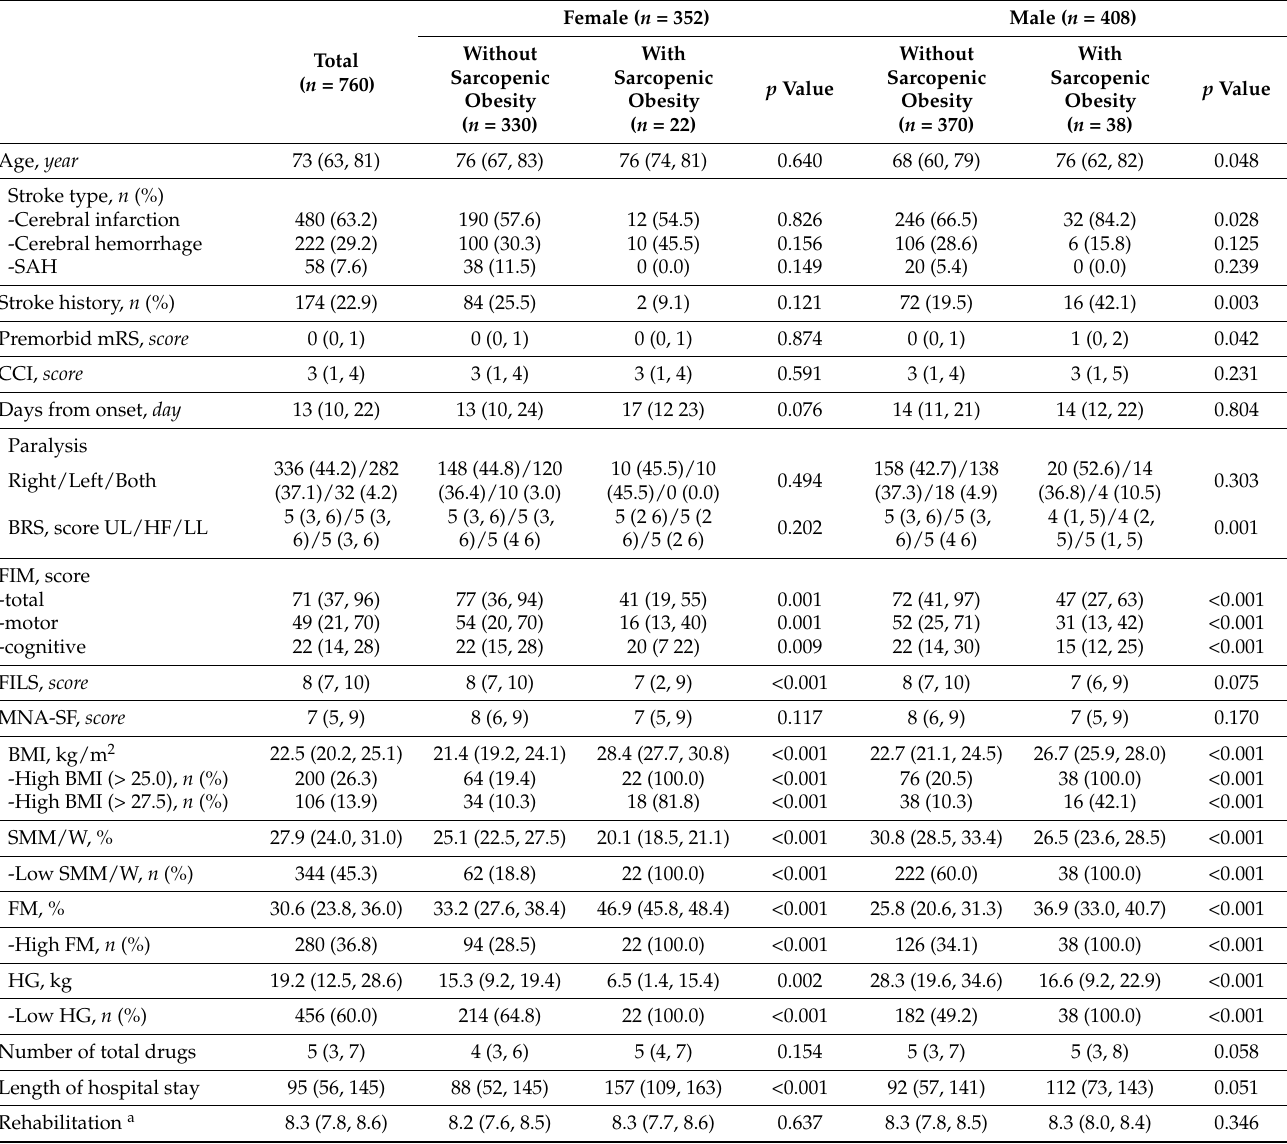
Table 1. Baseline patient characteristics and univariate analyses for variables between patients with and without sarcopenic obesity defined by ESPEN and EASO criteria 2022 in females and males using BMI > 25.0 kg/m 2 as the obesity